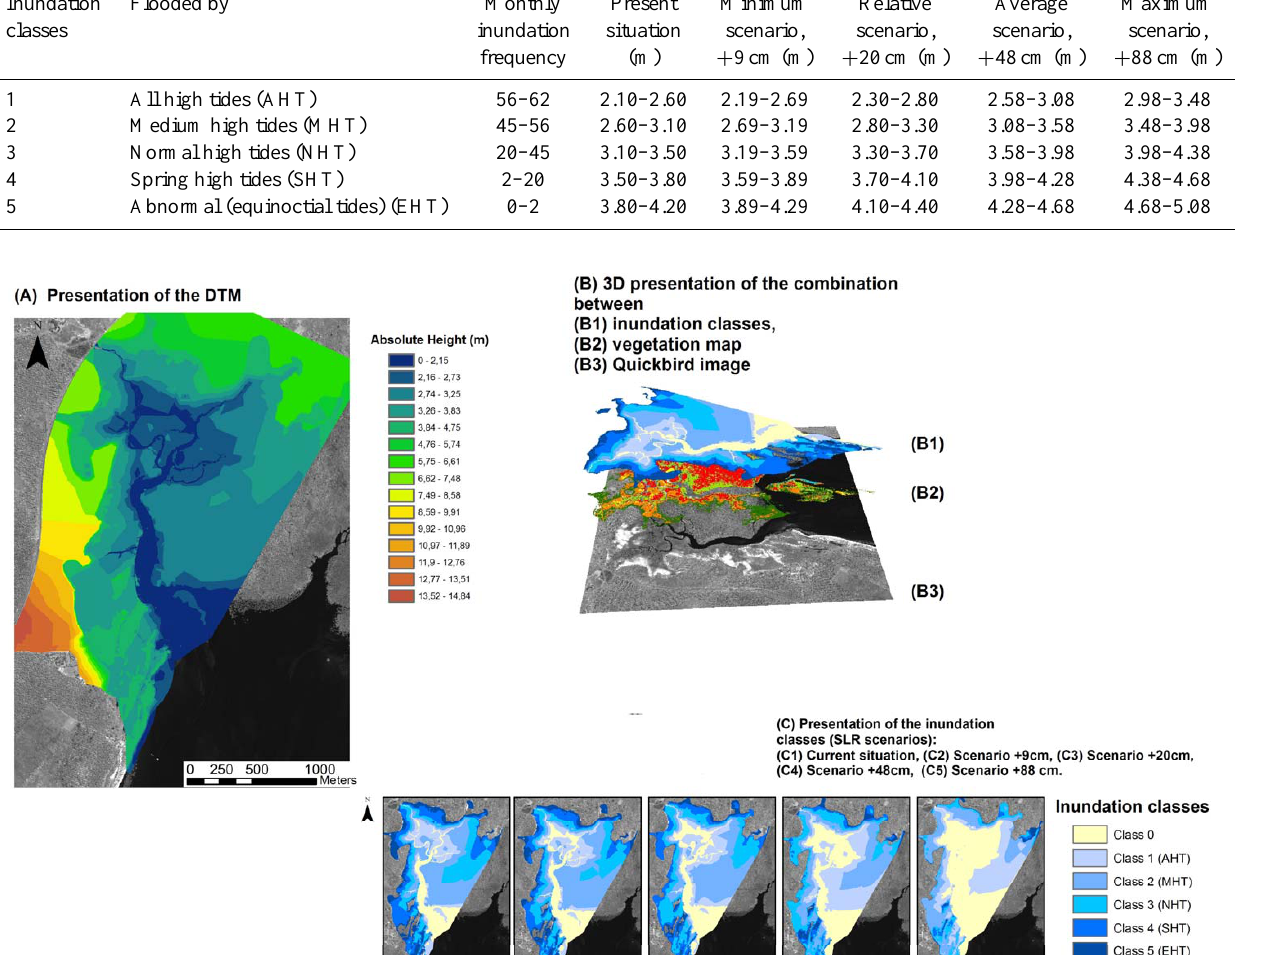
comparison between the reference map (Fig. 2C1) and the output maps after altering the height boundaries was assessed with an error matrix, giving overall (OA), user’s (UA) and producer’s accuracies (PA) (for calculations, see Appendix